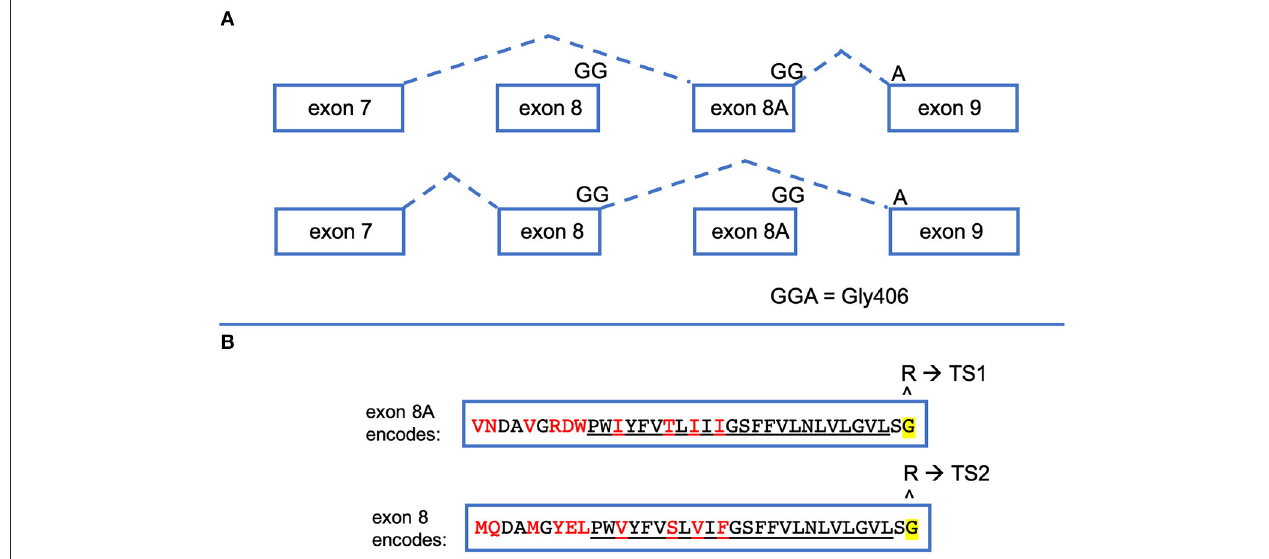
FIGURE 2 | CACNA1C exon 8 and exon 8A are alternatively spliced. (A) When CACNA1C mRNA is processed, exon 7 is spliced to either of two mutually exclusive exons, exon 8 or exon 8A, which is then spliced to exon 9. Exons 8 and 8A are the exact same size (104 bp). The final two nucleotides of exon8/8A and the first nucleotide of exon 9 encode Gly406, the amino acid most commonly implicated in TS. (B) Exons 8 and 8A produce slightly different protein products. Both encode 34 amino acids, differing by the 10 shown in red. The underlined amino acids make up the S6 segment of the first CACNA1C repeat. If the Gly406Arg variant is caused by nucleotide changes in exon 8A, the resulting phenotype is TS1. If the nucleotides in exon 8 are altered to change Gly406 to Arg, TS2